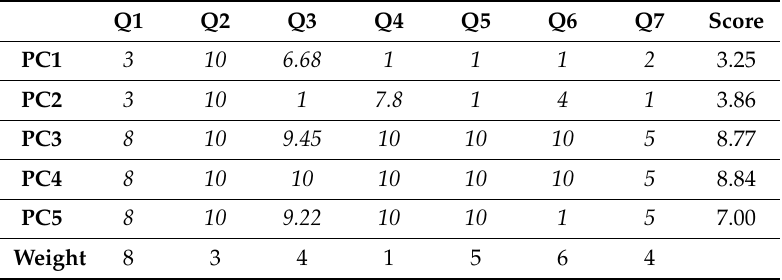
Table 1. Flexibility assessment for the considered process